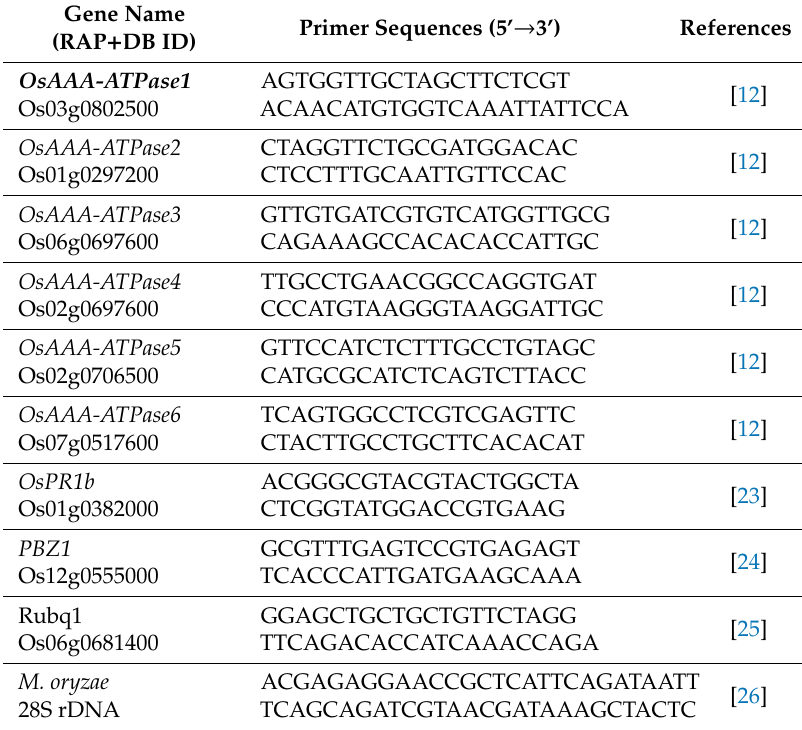
Table 1. Genes and primer sequences used for qRT-PCR